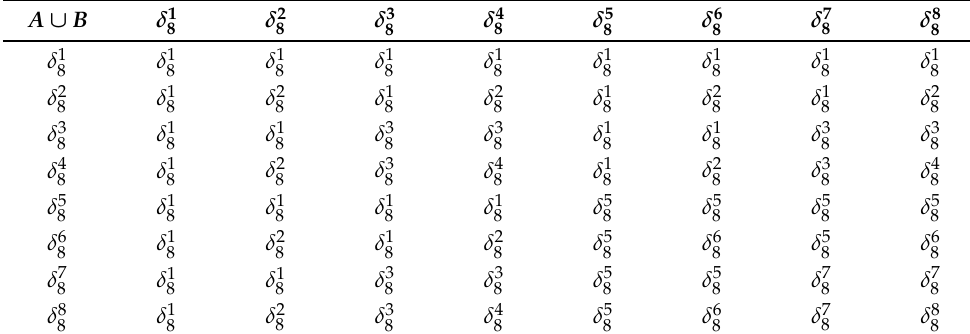
Table 5. Matrix of the union of 2 X .